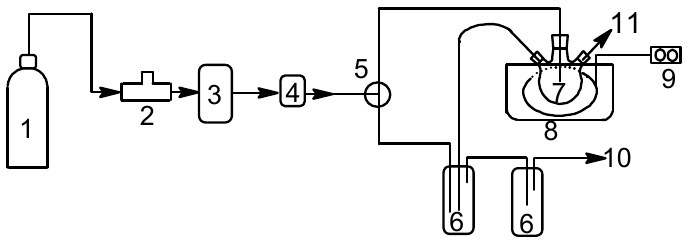
Figure 1. Diagram of the experimental setup. (1) oxygen cylinder; (2) mass flow controller; (3) ozone generator; (4) ozone monitor; (5) three-way valve; (6) KI traps (7) ozone reactor; (8) ultrasonic generator; (9) temperature control system; (10) gas outlet; (11) sampling.